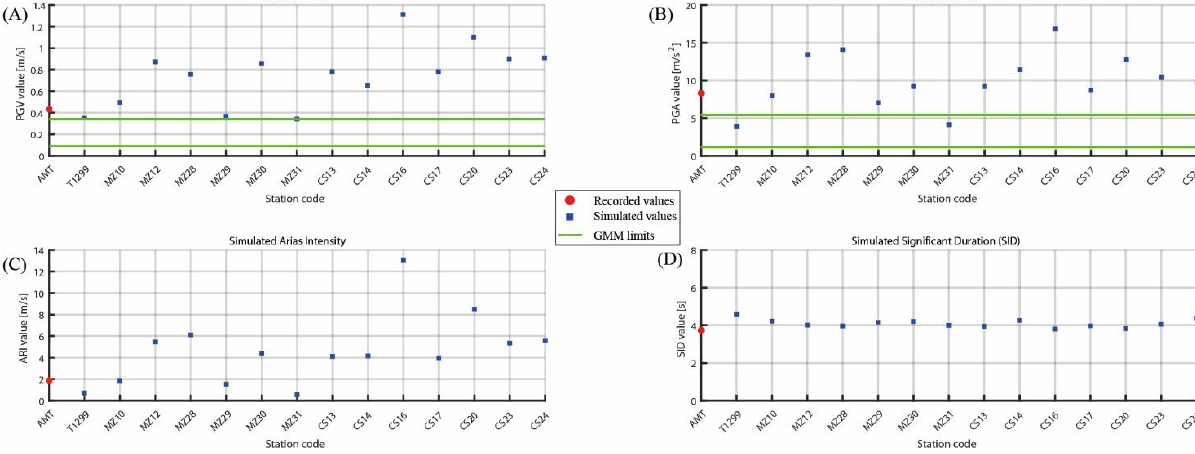
Figure 11. Comparison between the recorded (red dot) and simulated (blue square) intensity measures for Mw 6.0 (24 August 2016) at the stations in Amatrice (maximum horizontal components): ( A ) PGV; ( B ) PGA; ( C ) horizontal Arias intensity (AI); ( D ) significant duration (SID). Green lines are the GMM mean ±1 standard deviation [49] for Rjb = 1 km [38] and site class B (Vs30 = 670 m/s at AMT).